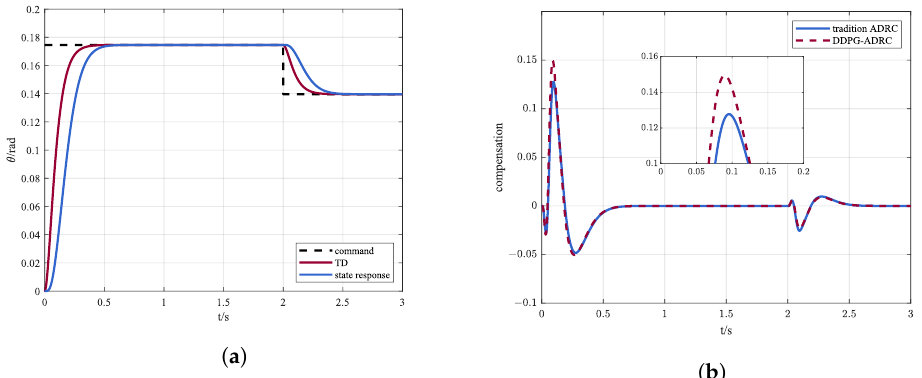
Figure 7. ( a ) Control instruction and state response via traditional ADRC and ( b ) comparison of compensation amount z 3 / b between traditional ADRC and DDPG-ADRC.